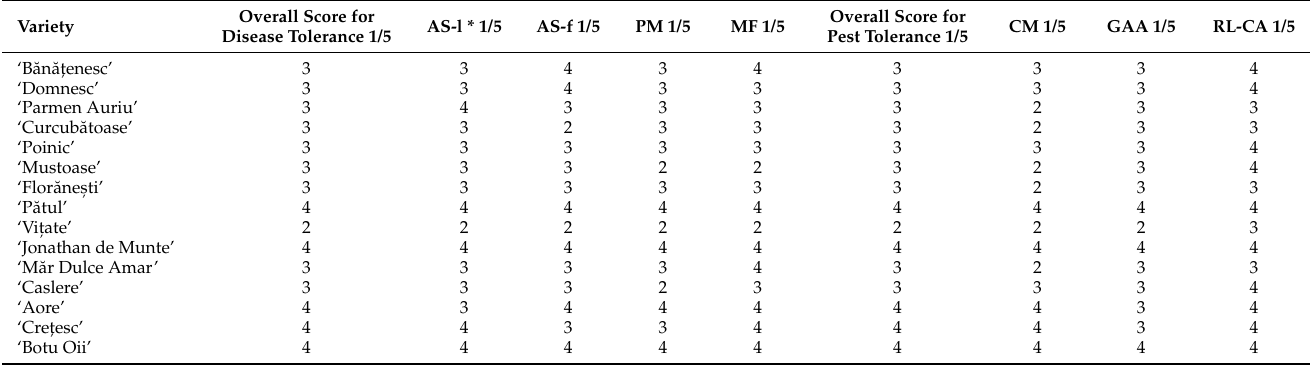
Table 8. Post-grafting disease and pest tolerance of the studied traditional apple cultivars, 2020–2022. Variety Overall Score for Disease Tolerance